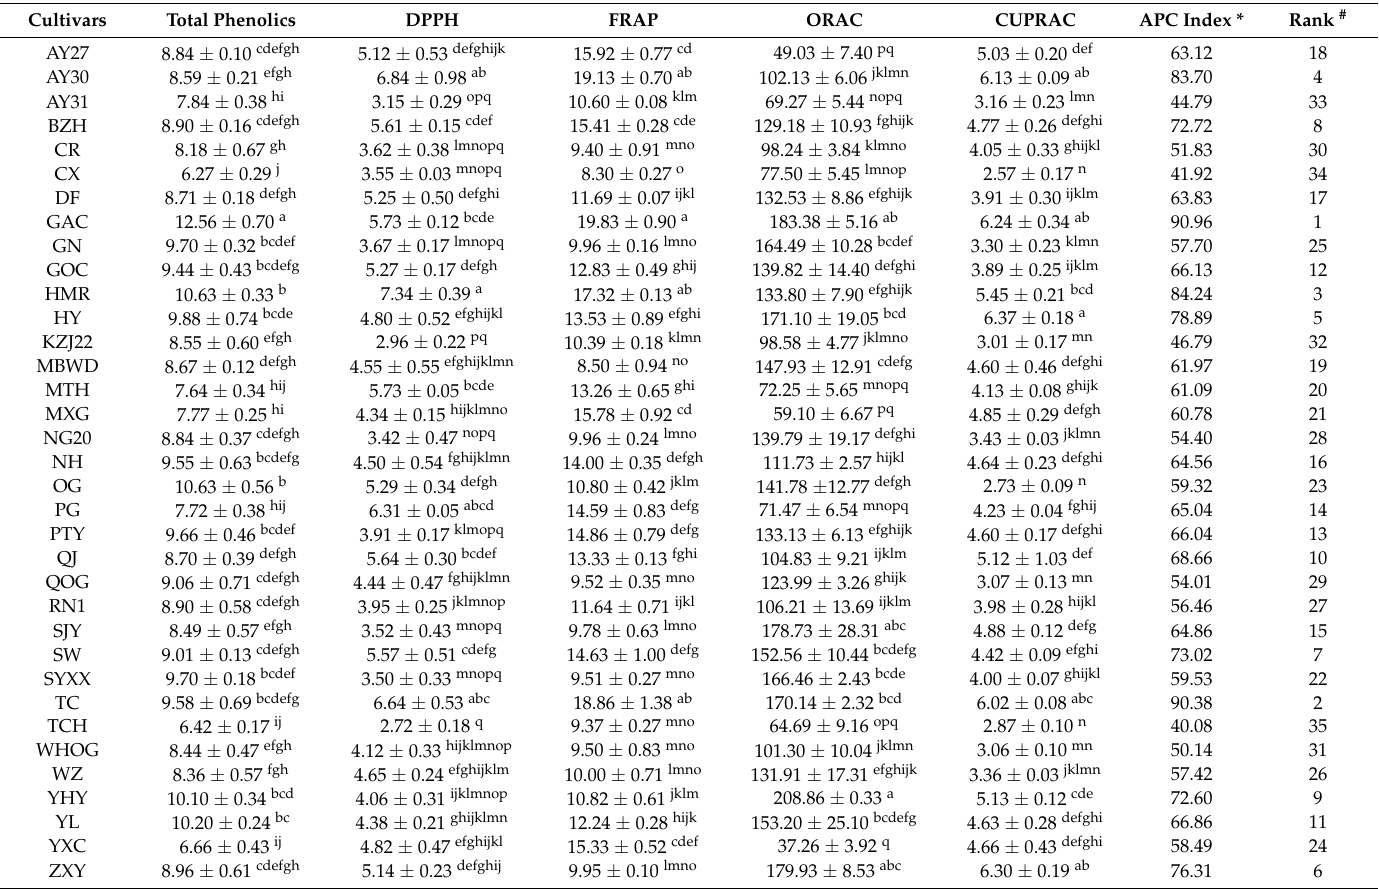
Table 4. Total phenolics and antioxidant properties of citrus fruit segment membrane of 35